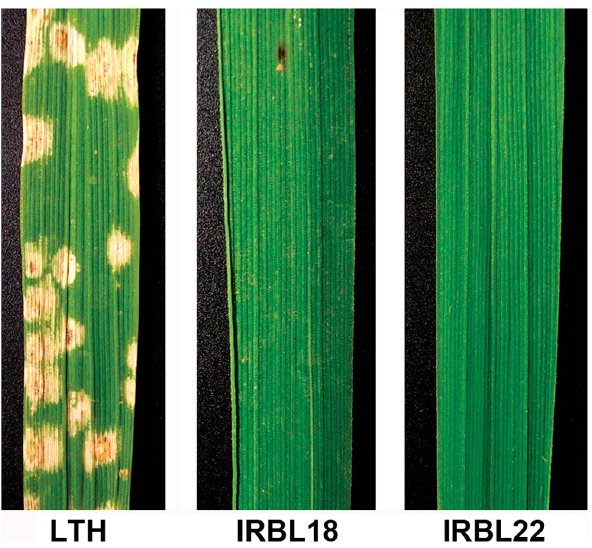
Figure 1. The disease symptoms on IRBL18, IRBL22 and LTH leaves at 7 days post-inoculation. The inoculation experiment was repeated three times (n=10 seedlings) with similar results.